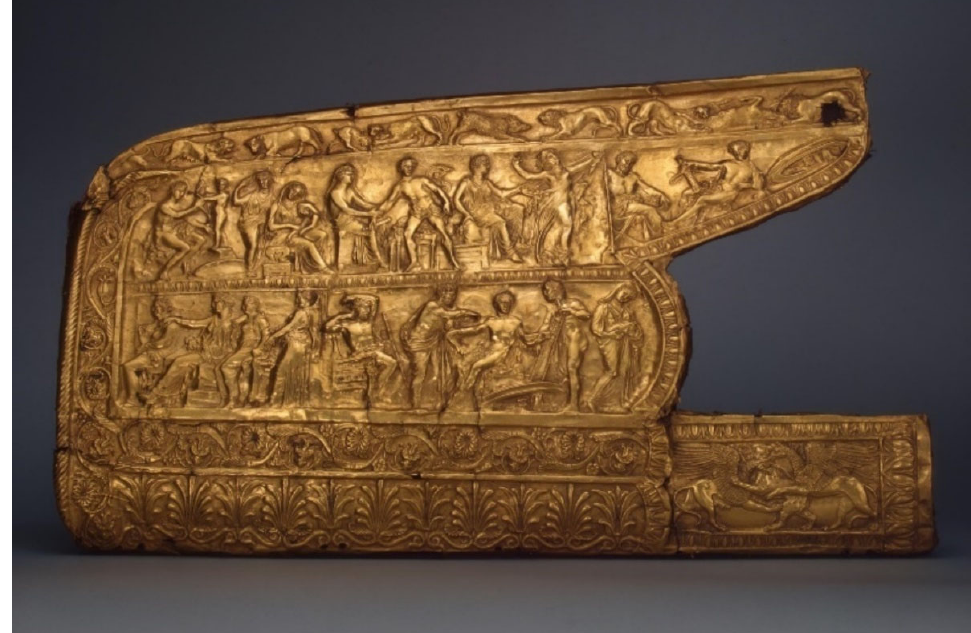
Figure 30. Gorytos cover (SHM inv. no. Дн .1863 ‐ 1/435); gold; Chertomlyk kurgan, Dnepropetrovsk region, Ukraine; 350–325 BC. [Image is used from www.hermitagemuseum.org (accessed 9 November 2022), courtesy of the State Hermitage Museum, St. Petersburg, Russia].